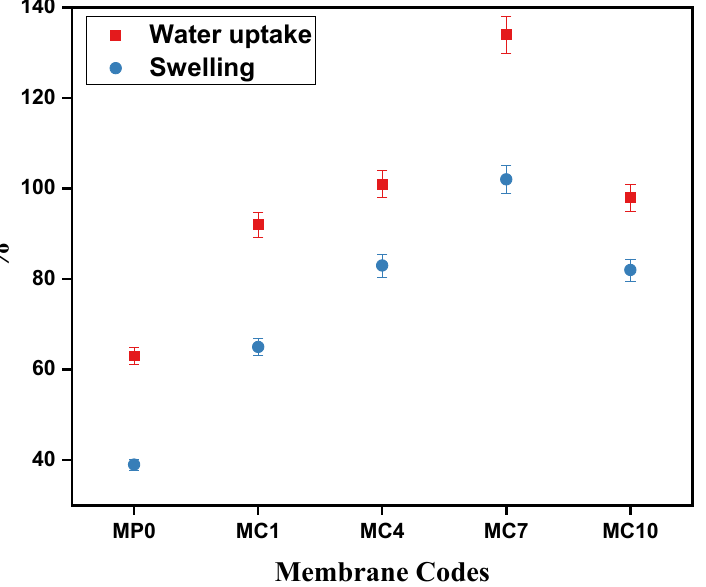
Figure 12. The WU and Swelling % of pristine PES membrane and mAC incorporated PES membranes. Sample codes are summarized in Table